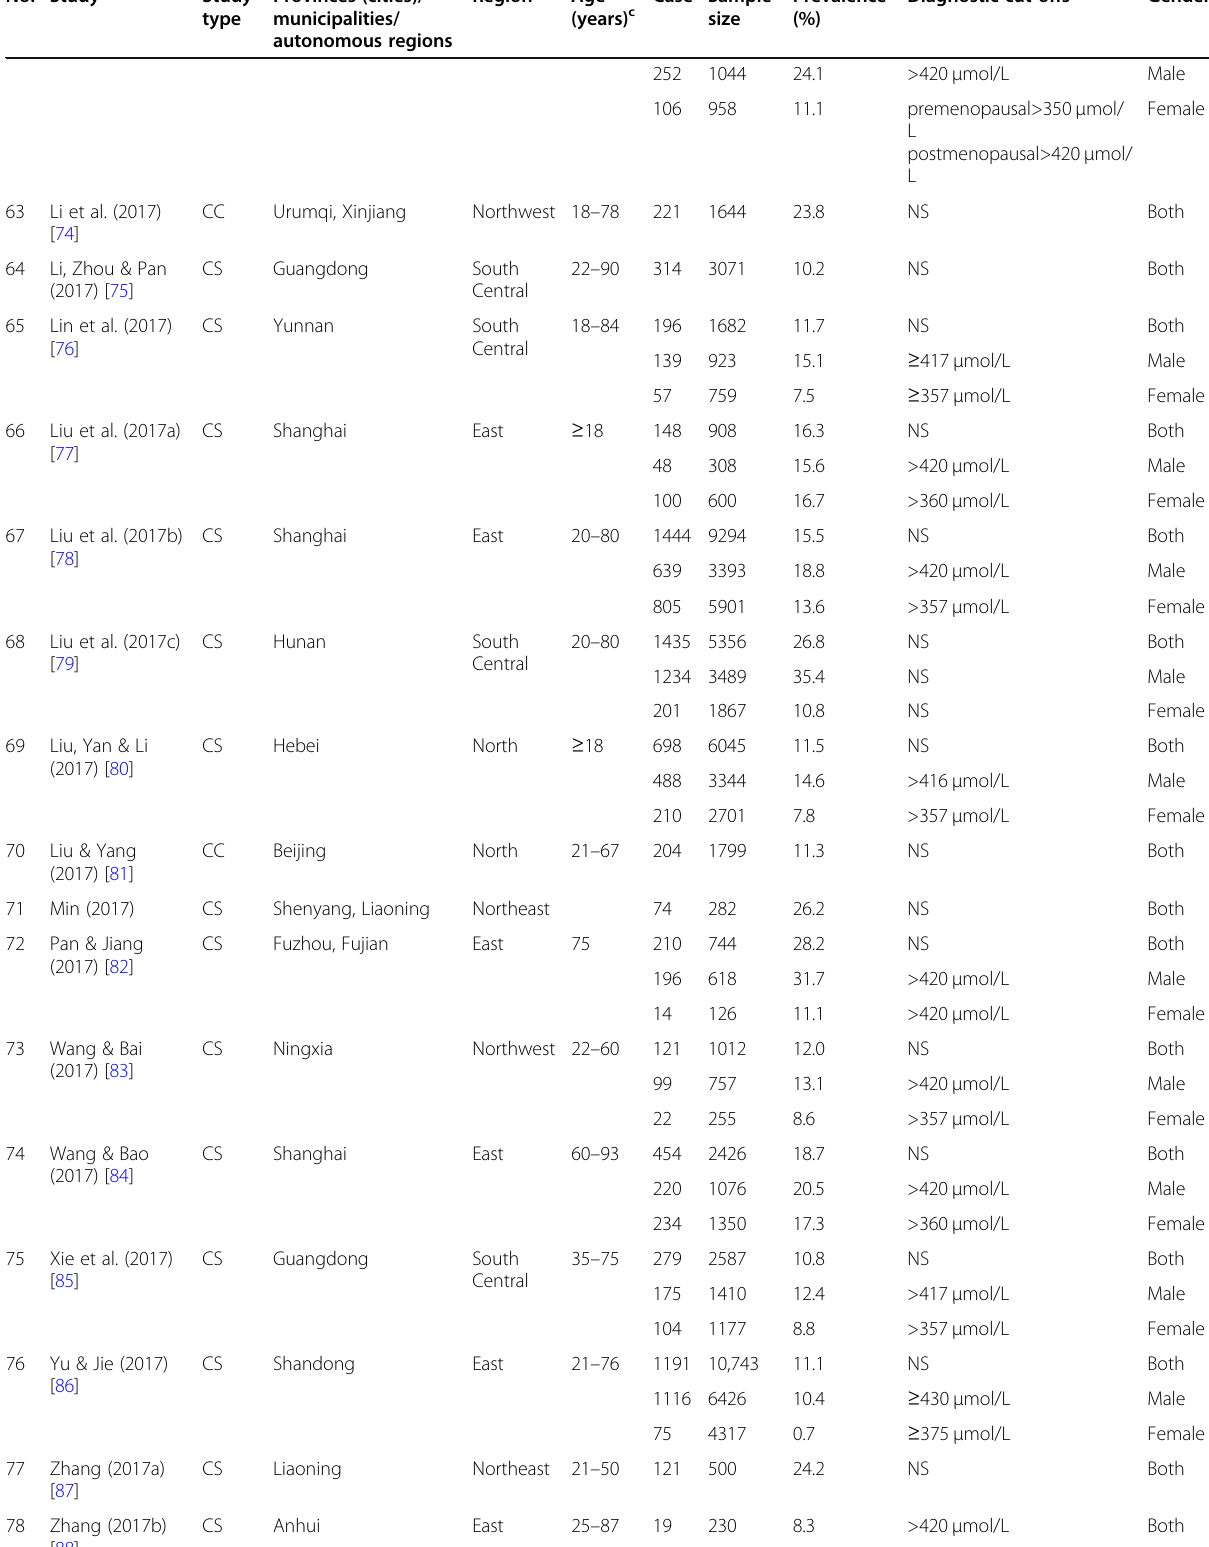
Table 1 Characteristics of the included studies in the systematic review and meta-analysis (Continued) No.